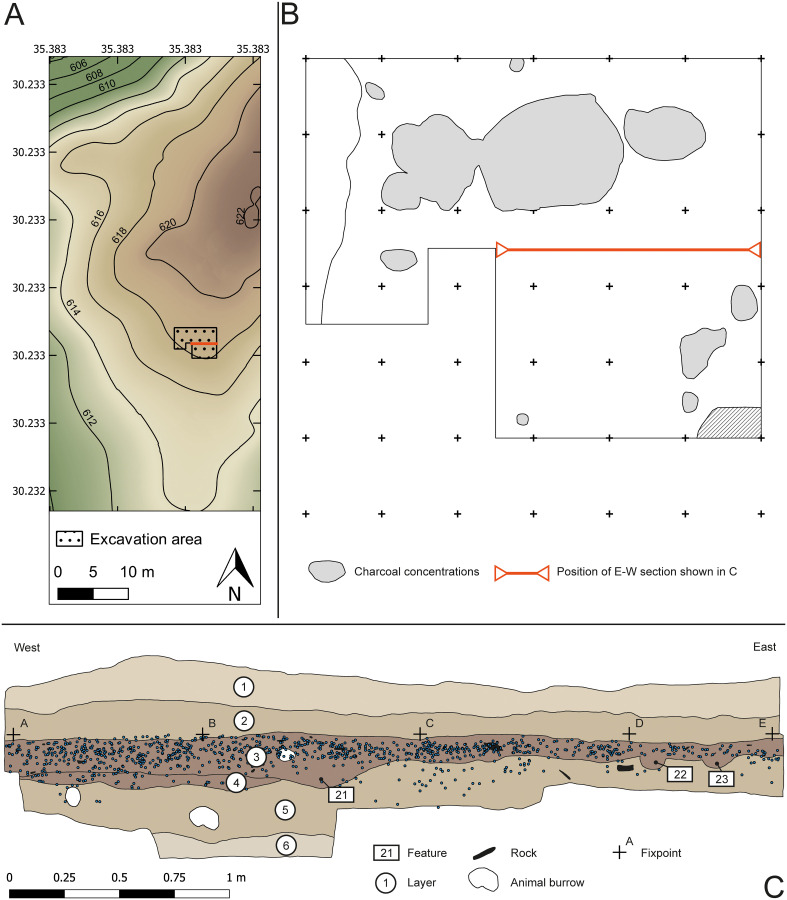
Excavation results from the Al-Ansab 1 settlement site.(A) Excavation area (shaded) located at the southern slope and close to the top of a Pleistocene sediment remnant. Red line, at northern limit of excavated area, indicates position of section below–(B) excavation area with evident features.—(C) Stratigraphic West-to-East section of the Al-Ansab 1 excavation (May 2017; see (A) for position of section)–numbering of layers: 1 fine horizontal layering of homogeneous fine sands, reddish light brown, with Calcium grains; 2 fine horizontal layering of homogeneous fine sands red-brown; 3 Al-Ansab 1 archaeological find layer (including stone artefacts, bones, ochre, charcoal etc.), of slightly consolidated fine sand, greyish light-brown, with anthropogenic features (framed numbers: 21, 22, 23), such as fireplaces and pits; 4 sediment lens of greyish light-brown fine sand with few artefacts; 5 fine horizontal layering of red fine sand, interlaced with fine gravel, quite loose, with occasional krotovinas; 6 fine horizontal layering of red, homogeneous fine sand and silt.